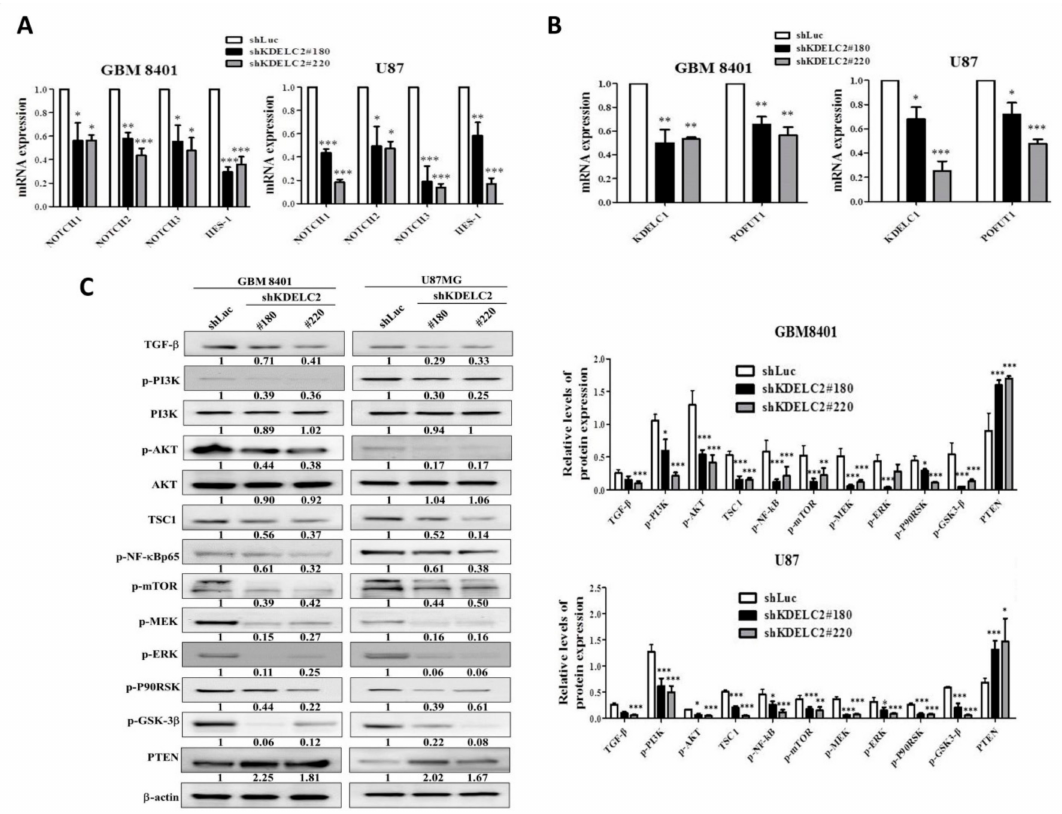
Figure 9. KDELC2 knockdown downregulated Notch signaling expression and PI3k / mTOR / Akt, MAPK / ERK, and NF / kB signaling pathways. ( A ) Knockdown of KDELC2 decreased Notch receptors 1–3, HES-1, and ( B ) KDELC1 and pofut 1 mRNA expression. ( C ) Western blot analysis proved that knockdown of KDELC2 inhibited TGF- β , NF-kB, and PI3K / mTOR / Akt signaling pathways. Bars, means ± SEM. * p < 0.05; ** p < 0.01; *** p < 0.0001. 3.11. KDELC2 Knockdown Promoted TMZ Cytotoxic E ff ect by Decreasing MGMT